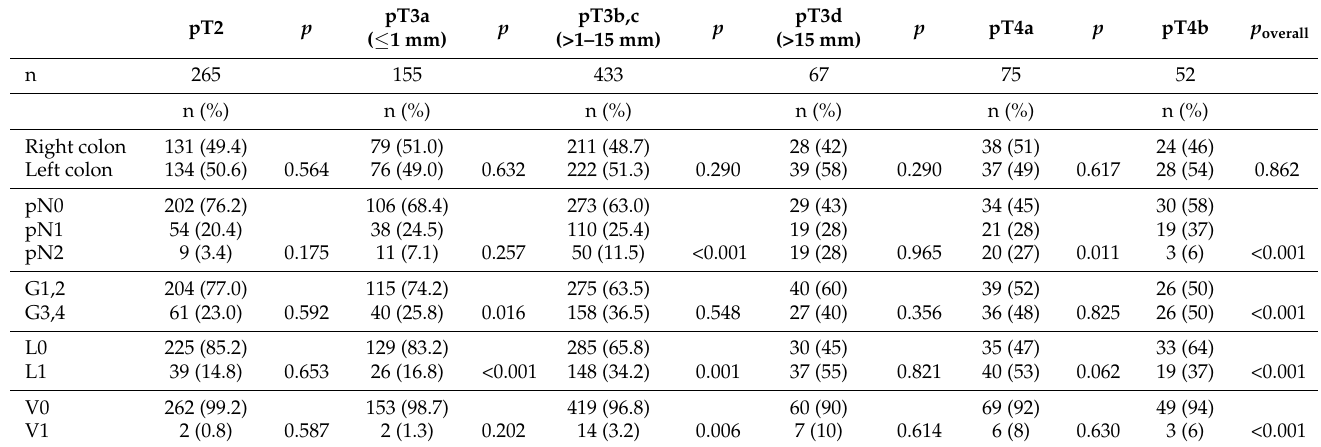
Table 2. Distribution of prognostic factors (n =